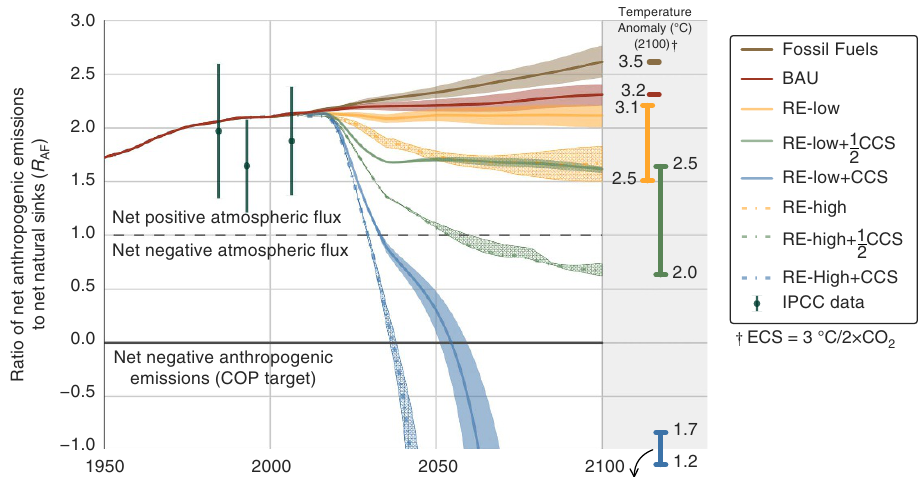
Figure 1 | Atmospheric carbon flux ratios. Ratios are calculated annually as the ratio of net anthropogenic carbon emissions (energy and land-use emissions minus anthropogenic sinks) to net carbon sequestration by global plant, soil and ocean systems. Shaded ranges around the central value of each scenario indicate sensitivity of results to primary energy demand. Global surface temperature anomalies projections ( D T ) in 2,100 are indicated at the right, where each coloured bar treats the RE-Low and RE-High scenarios as the endpoints of a continuous range of energy sector decarbonization, plus a fixed rate of CCS. Historical values of R AF and associated errors ( cf. equation (12)) from the IPCC are indicated by green bars 3